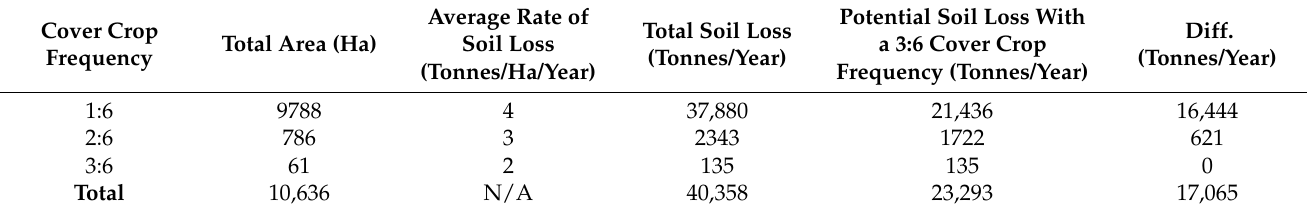
Table 2. Average rate of soil loss for different cover crop frequency